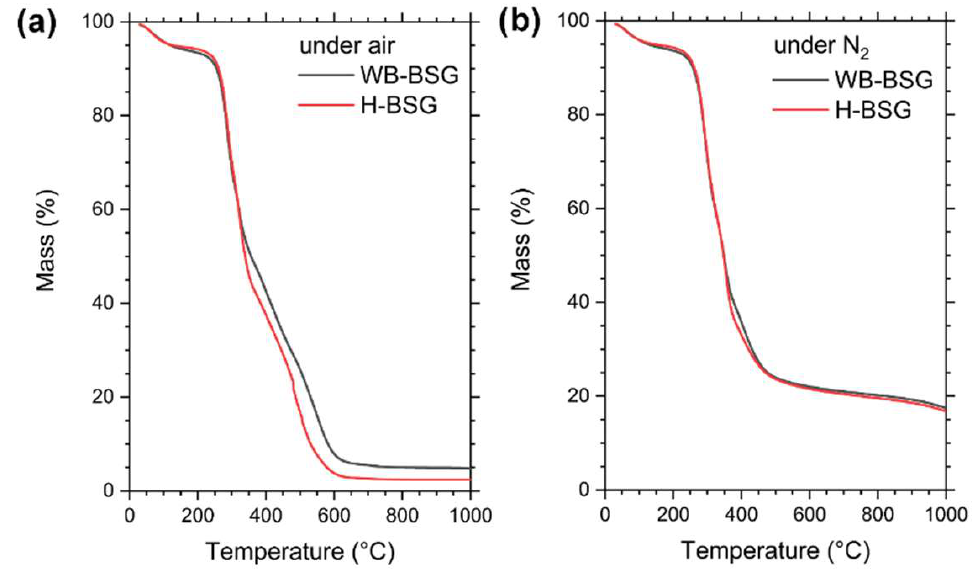
Figure 2. Thermogravimetric analysis of H-BSG (red) and WB-BSG (grey) studied in the range from 30 °C to 1000 °C with a heating rate of 10 °C/min under ( a ) atmospheric conditions and ( b ) N 2 at constant flow of 40 mL/min.